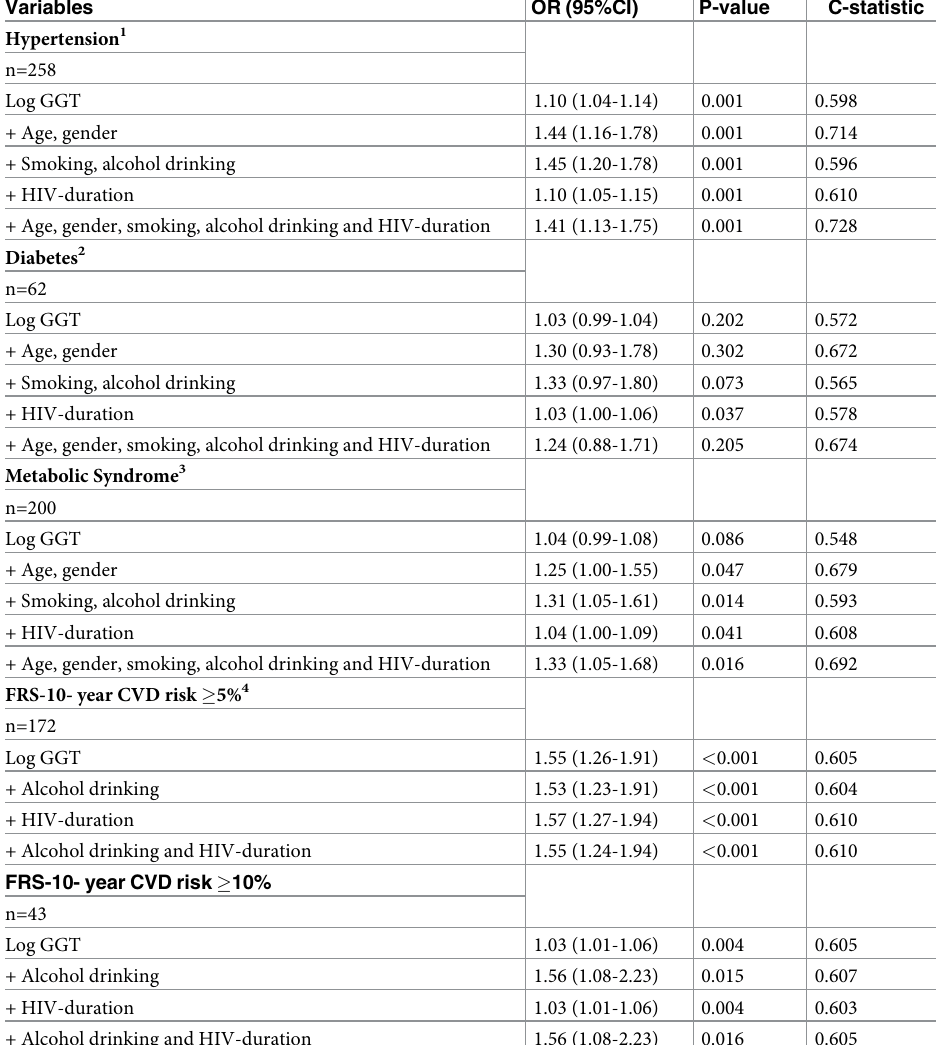
Table 3. Logistic regressions for the associations of gamma-glutamyl transferase (GGT) with cardio-metabolic diseases and Framingham cardiovascular risk, N=709.